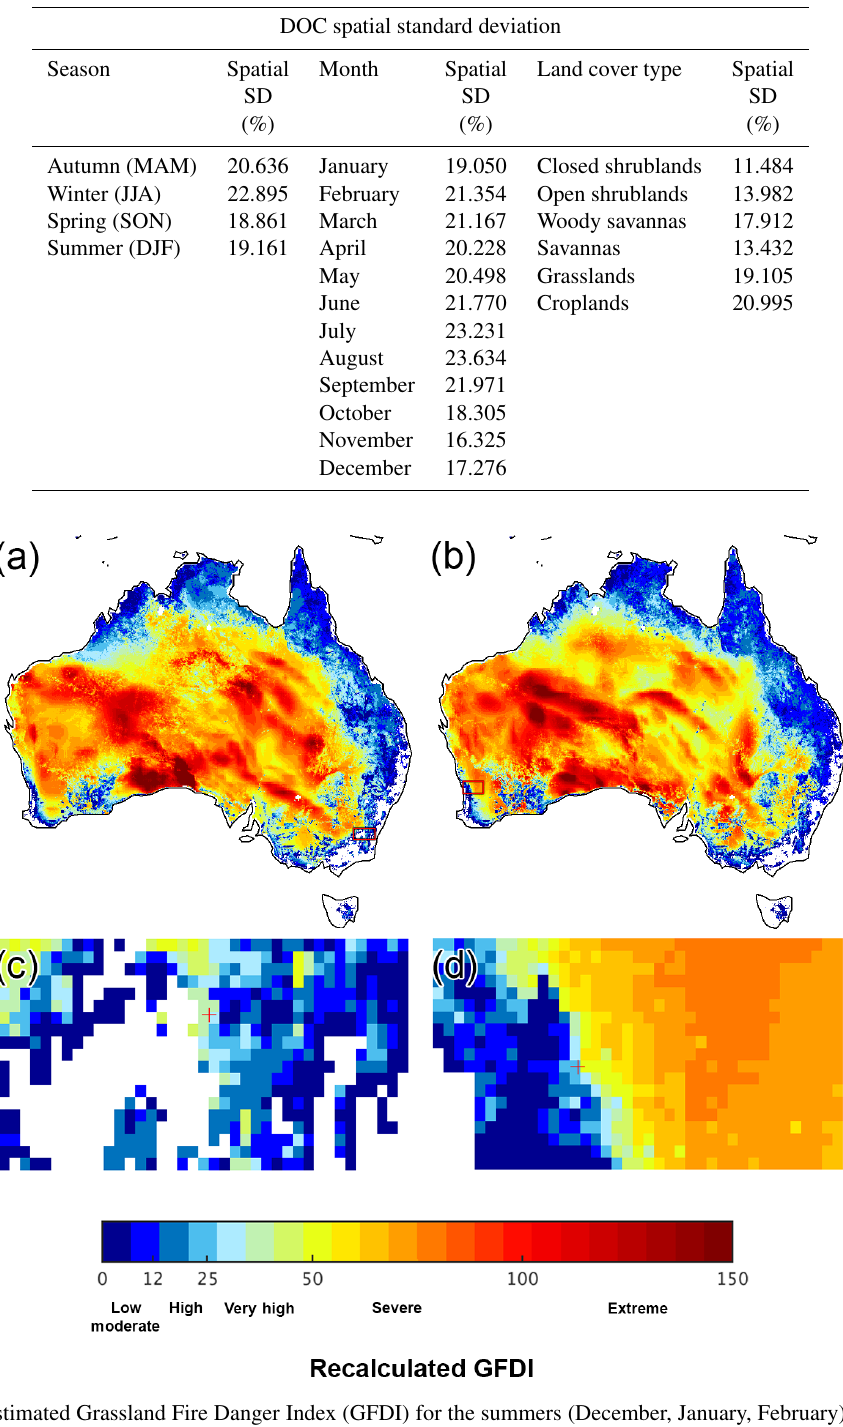
Table 2. Spatial standard deviation of estimated degree of curing (DOC) by season, month, and land cover type from 4 July 2002 to 26 June 2011.